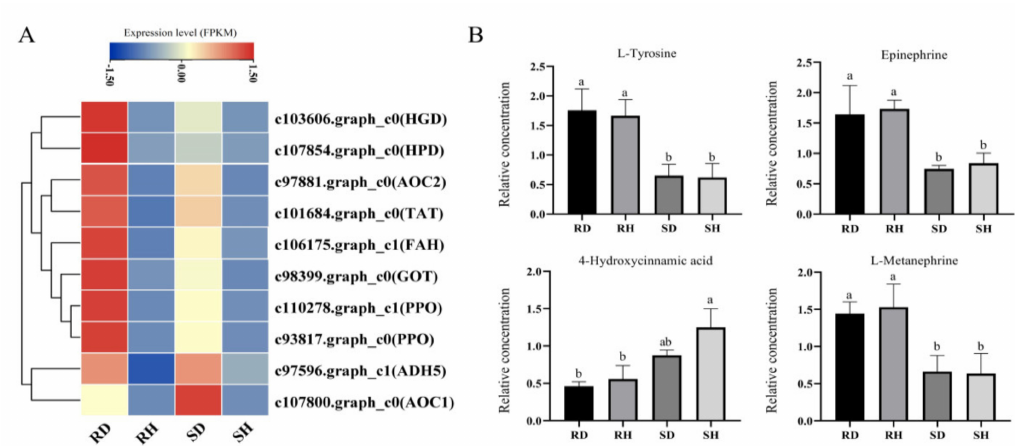
Figure 6. ( A ) Expression of DEGs in tyrosine metabolism pathway among the four sample groups, data of each row was standardized. ( B ) Relative concentration of four DAMs in tyrosine metabolism pathway among the four sample groups, different letters represent significant difference at p < 0.05 by